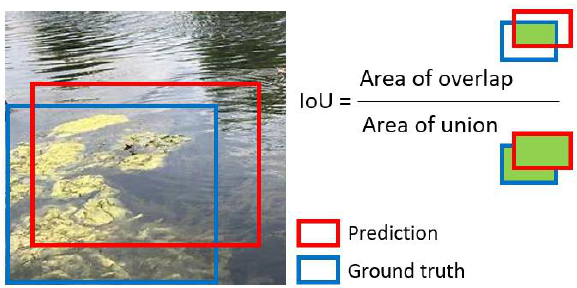
Figure 6 . Intersect over Union (IoU), visual explanation